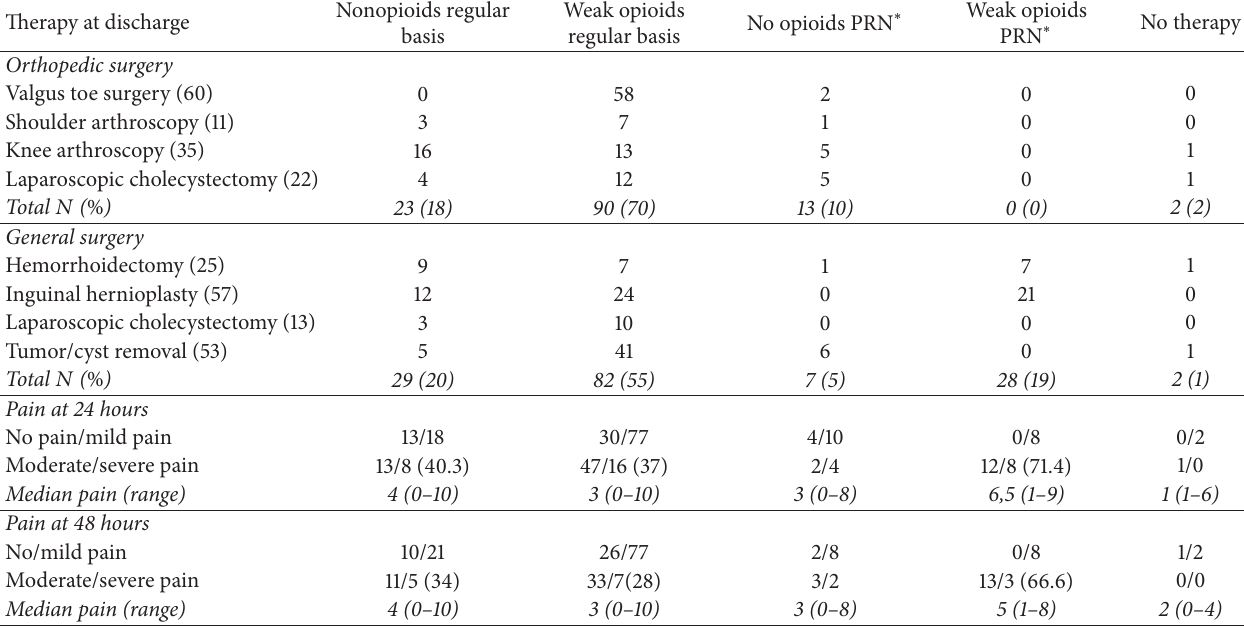
Table 4: Discharge therapies by type of surgery and administration